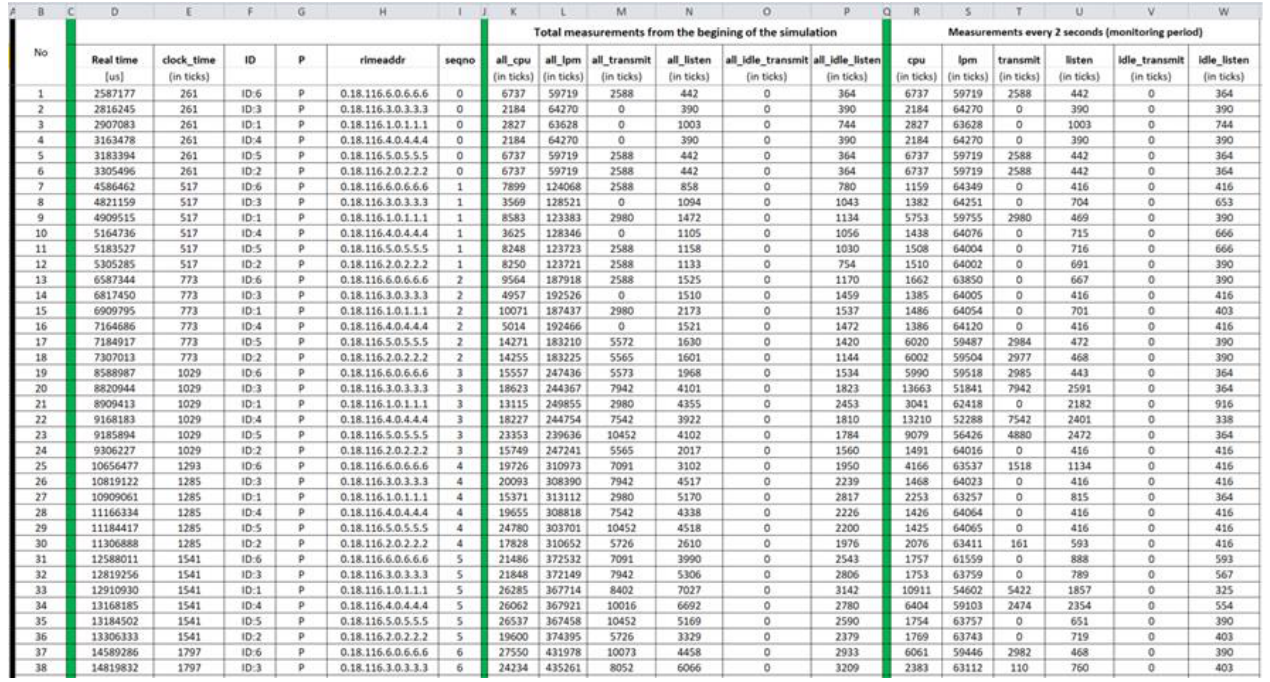
Figure 11. Benign “pwrtrace.csv”— 1 to 38 records.